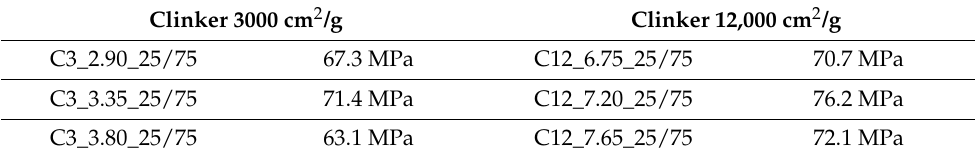
Figure 13. Change of ettringite main peak count for the clinker with 3000 cm²/g (a) and 12,000 cm²/g ( b ). In addition, compressive strength values were determined on 2 cm cubes after 24 h hydration to check the strength development. All samples were tested three times and the mean value was calculated. The results are shown in Table 4. For both compressive strengths determined, the optima could be set in the determined range. Table 4. Compressive strength values for the clinker with coarse and fine grinding fineness.